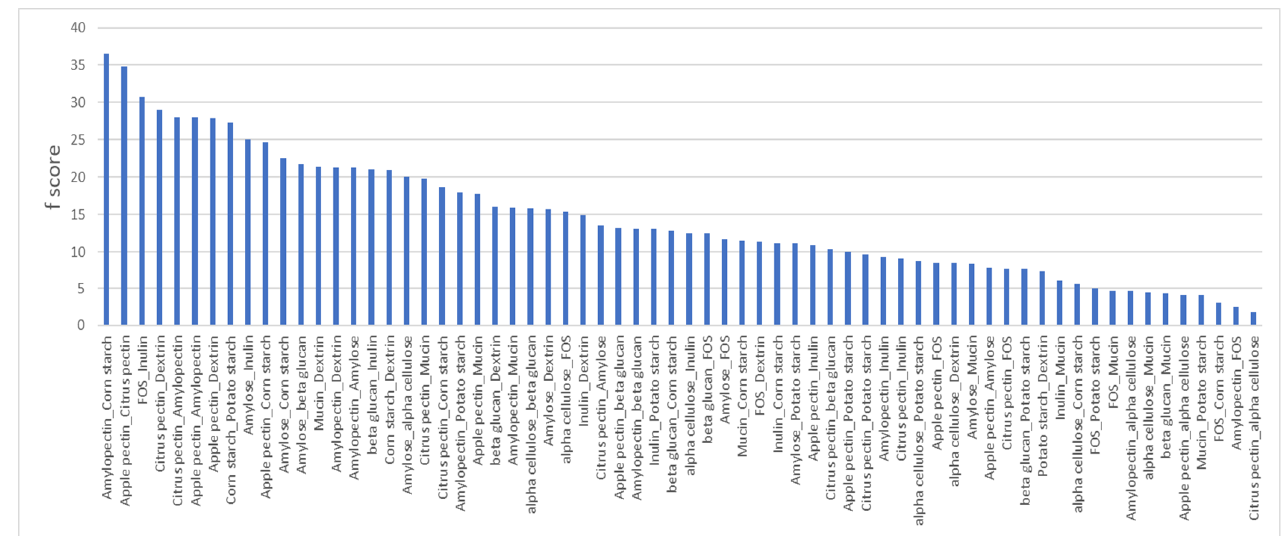
Figure 2. Pairwise analysis of prebiotics. The number of taxa impacted uniquely or that were in common for 66 prebiotic pair combinations. F-scores were calculated by dividing the sum of taxa impacted by prebiotics individually and dividing this figure by the number of taxa impacted by both.